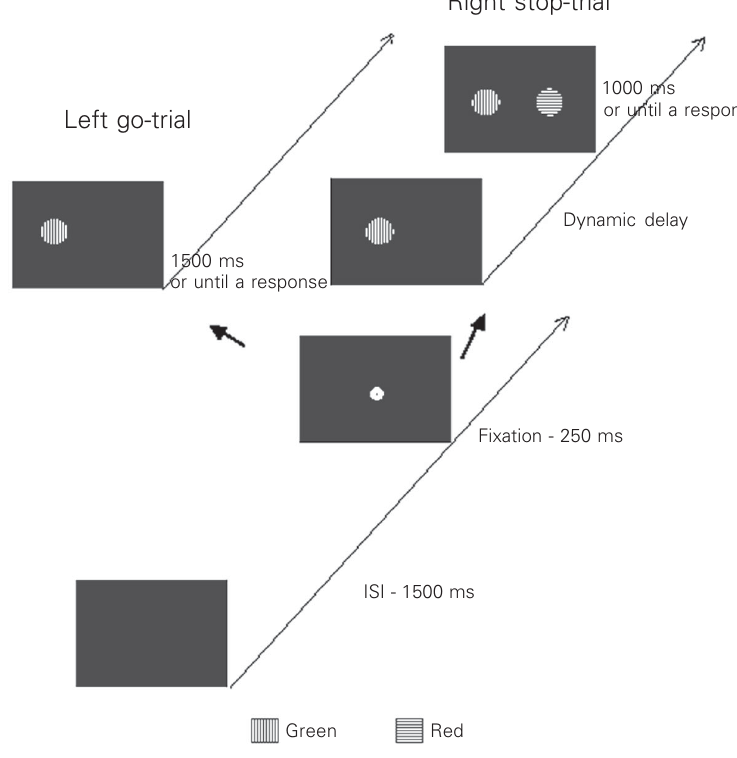
Figure 2. Diagram illustrating the stop-task. ISI = inter-stimuli